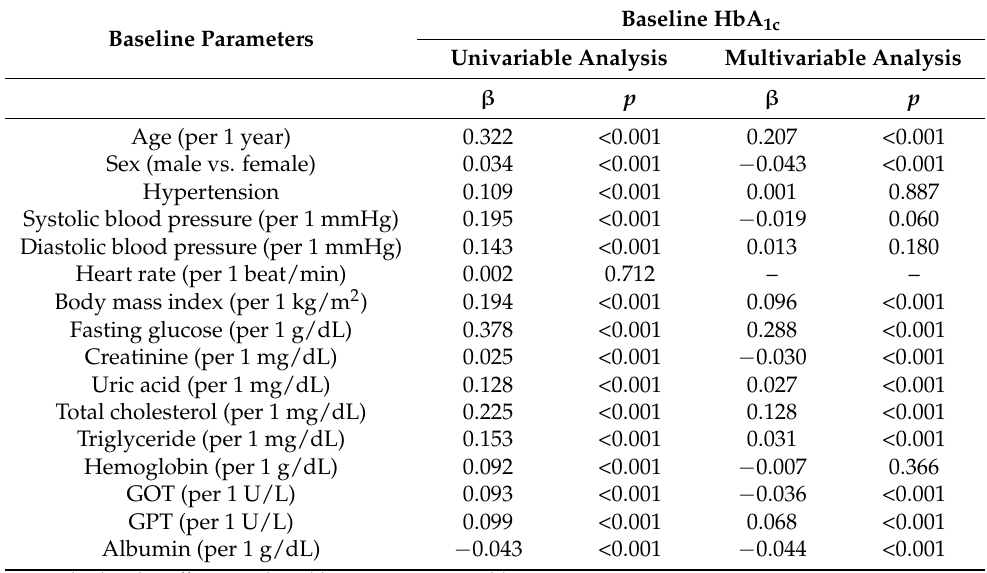
Table 2. Univariable and multivariable correlates of baseline HbA 1c